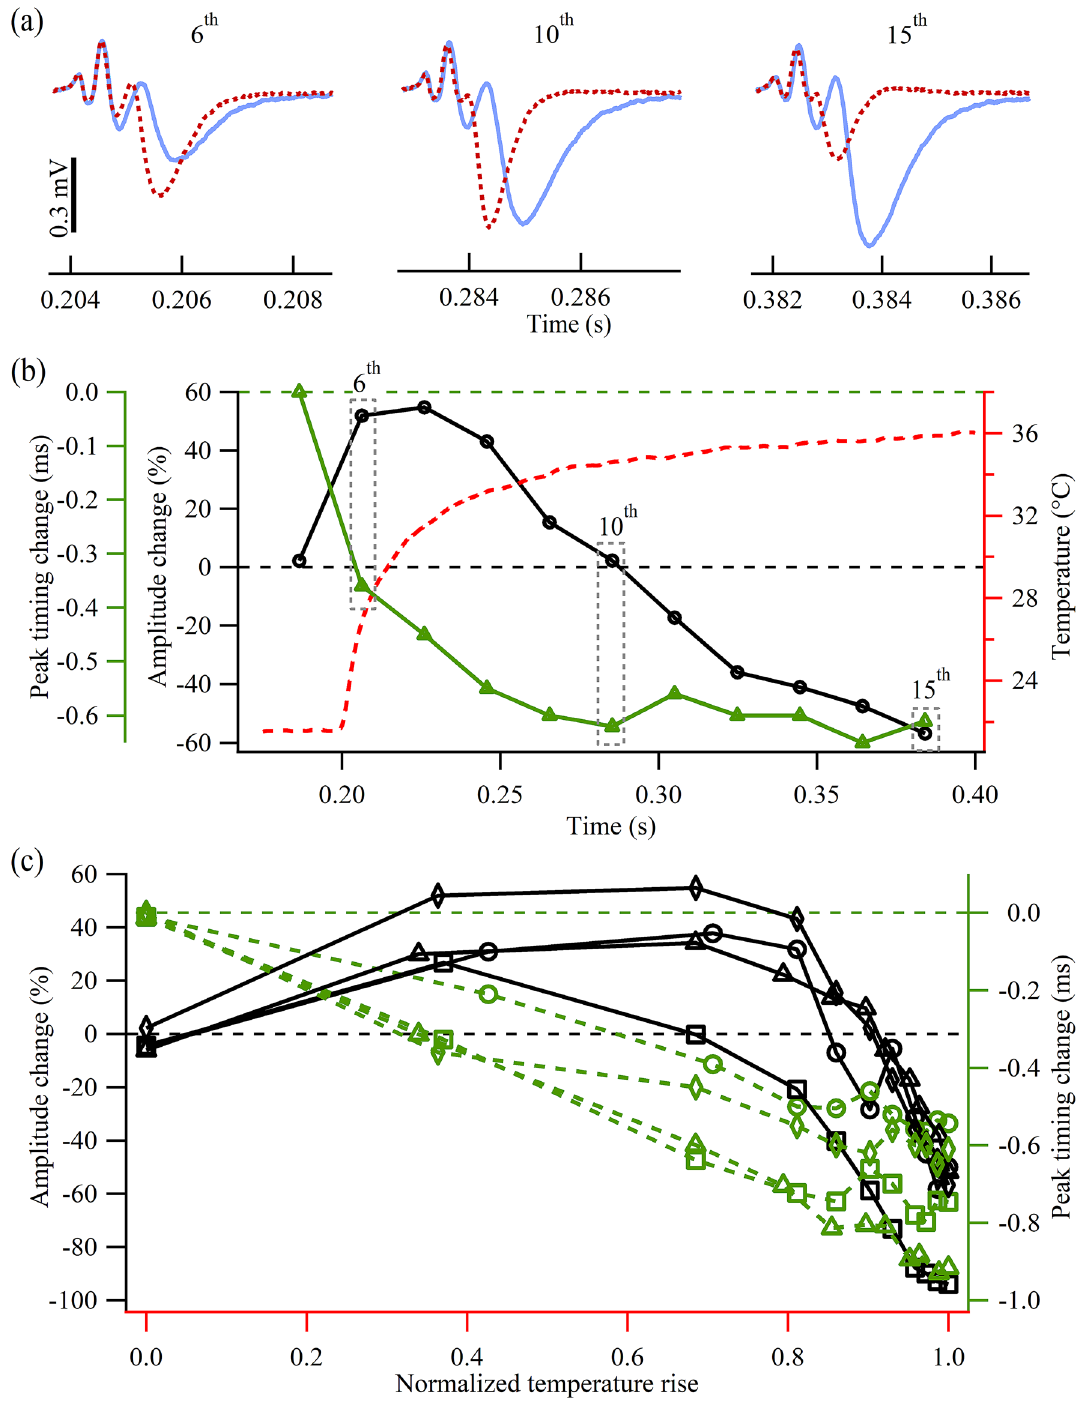
Figure 3. Modulation of the synaptic transmission during the rising phase of the IR light-induced temperature rise. ( a ) Traces showing the EPSCs under control (solid blue line) and IR light illumination (dashed red line) conditions with Protocol 2. The numbers (6th, 10th, and 15th) represent the order of the EPSCs within the train. Each trace was averaged over 50 trials. All traces share the same vertical scale bar on the left. ( b ) Plot showing the normalized EPSC amplitude changes (black circles), differences in the timing of the EPSC peak (green triangles), and localized temperature transient (dashed red) caused by an IR light pulse of 10 mW. ( c ) Normalized EPSC amplitude changes (left axis) and changes in the timing of the EPSC peak (right axis) in response to the normalized IR light-induced temperature rise (x axis). Each type of symbols represents a set of data obtained from one preparation dissected from an individual animal ( N =